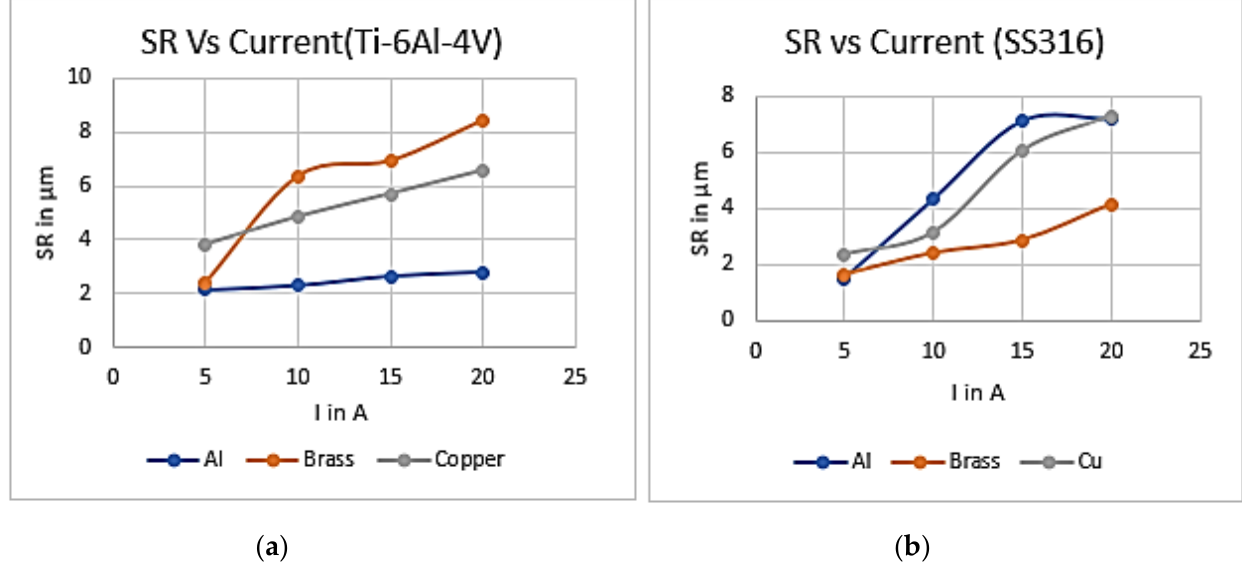
Figure 9. Variations of SR for ( a ) Ti-6Al-4V and ( b ) SS316 using different tools. Figure 7a represents the variations of MRR of Ti-6Al-4V material at different currents using different tool materials. It is clearly obvious from this graph that the MRR values drastically increase with current when the Cu tool is used compared to the Al and brass tools. Hence, Cu is the best tool material among these three tools so far as the MRR is concerned. The reason for higher MRR in the case of Cu is explained